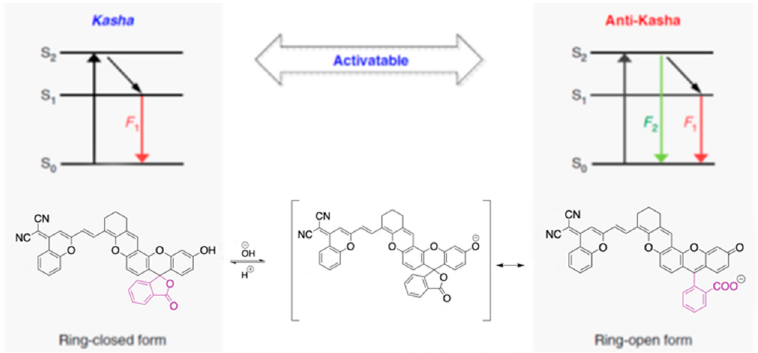
Figure 24. Schematic illustration of spirolactone switch-controlled 97 for tuning anti-Kasha/Kasha properties. Reprinted from [83].